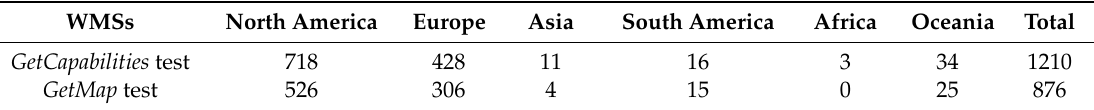
Table 1. The WMSs selected in intensive monitoring.